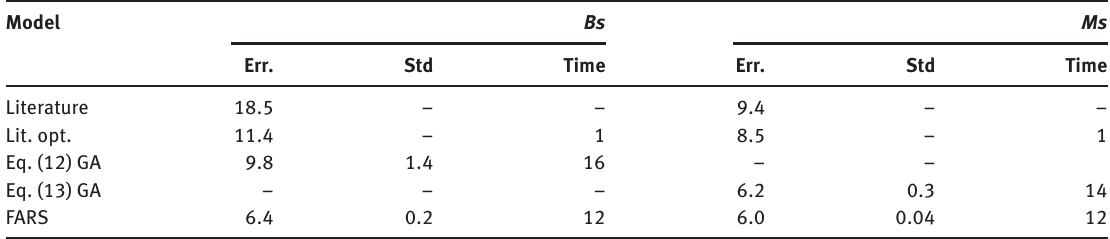
Table 7: Comparison among the Different Approaches Tested for the Bs and Ms Estimation: Time Is Expressed in Seconds, Error = 0.5, r = 0.05) and for Eq. (13) GA are ( r = 0.7, r = 0.2). in K; The Optimal Recombination Rates for Eq. (12) GA are ( r c m c m Model Bs Ms Err. Std Time Err. Std Time Literature